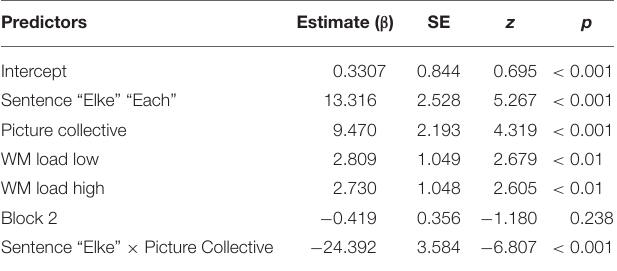
TABLE 1 | Overview of the final model for the responses to the test items, with reference levels: Sentence: “De” “The,” Picture: Distributive, WM Load: No Load, and Block: